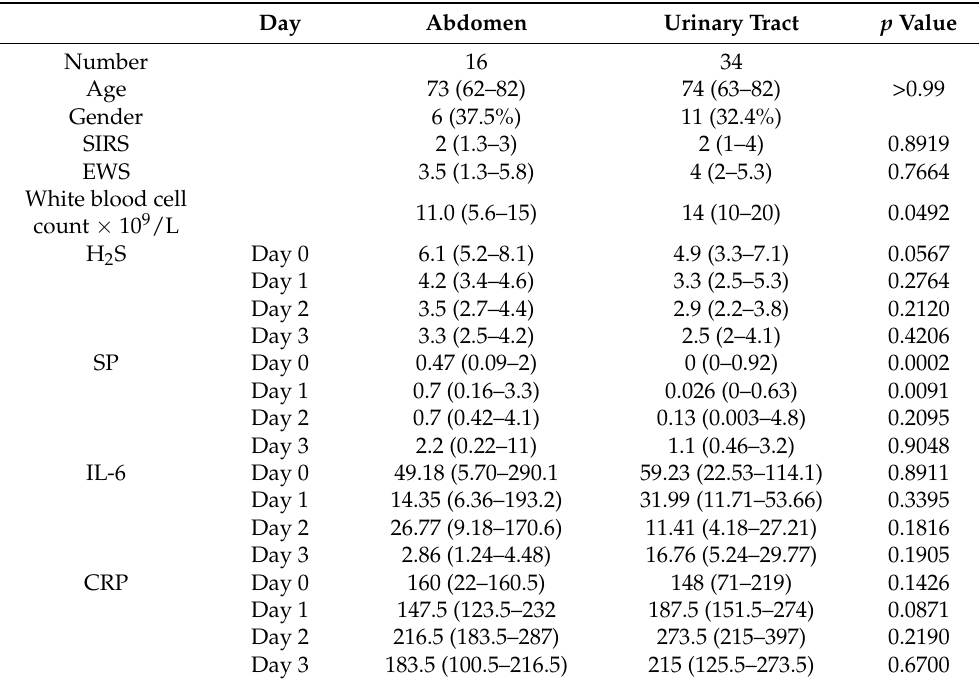
Table 2. Comparison of plasma H 2 S, SP, IL-6, and CRP concentrations between urinary tract and abdominal infections. The SIRS and EWS scores and white blood cell count were obtained from observations and samples taken during the first 12 h after admission. Data are expressed as the median with the interquartile range unless otherwise